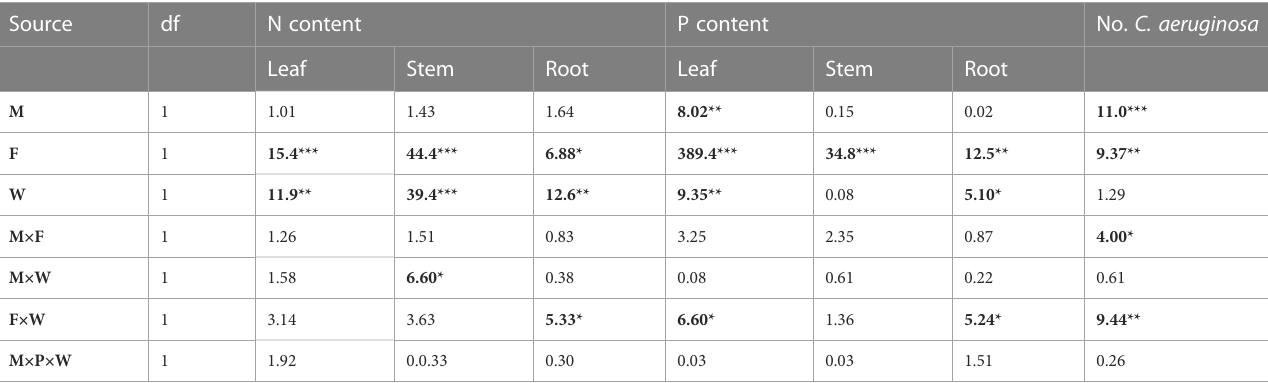
TABLE 2 General Linear Mixed Models (GLMM) of the effects of inoculation with arbuscular mycorrhizal fungi (M), fertilization (F) and water addition (W) on plant nitrogen (N) and phosphorus (P) concentrations in leaves, stems and roots of Artemisia ordosica plants grown in the greenhouse, as well as generalized linear mixed model ( “ poisson ” distribution) of the effects of M, F, and W treatments on the abundance of insect herbivore Chrysolina aeruginosa colonizing each plant in the fi eld. Source df N